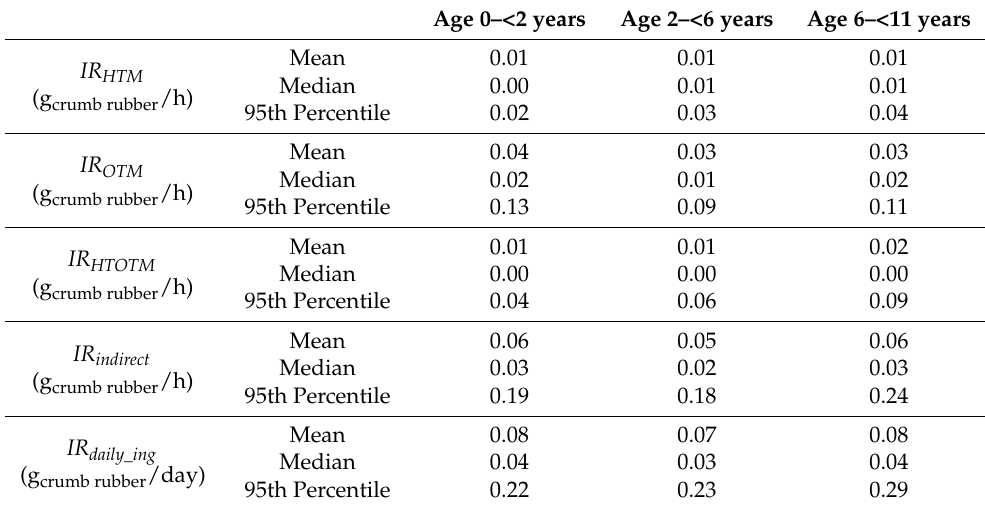
Table 5. Estimated children’s indirect ingestion